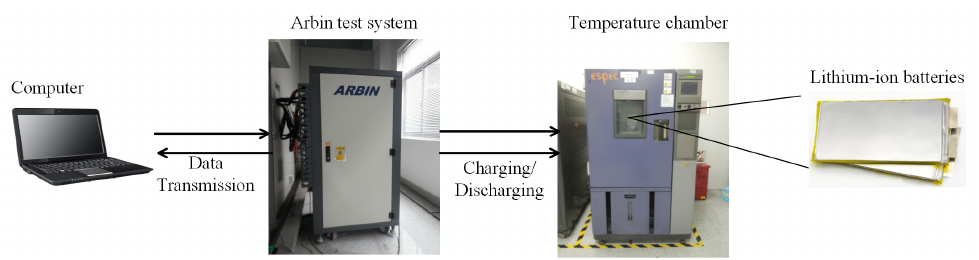
Figure 4. The scheme of the test platform of lithium-ion batteries.